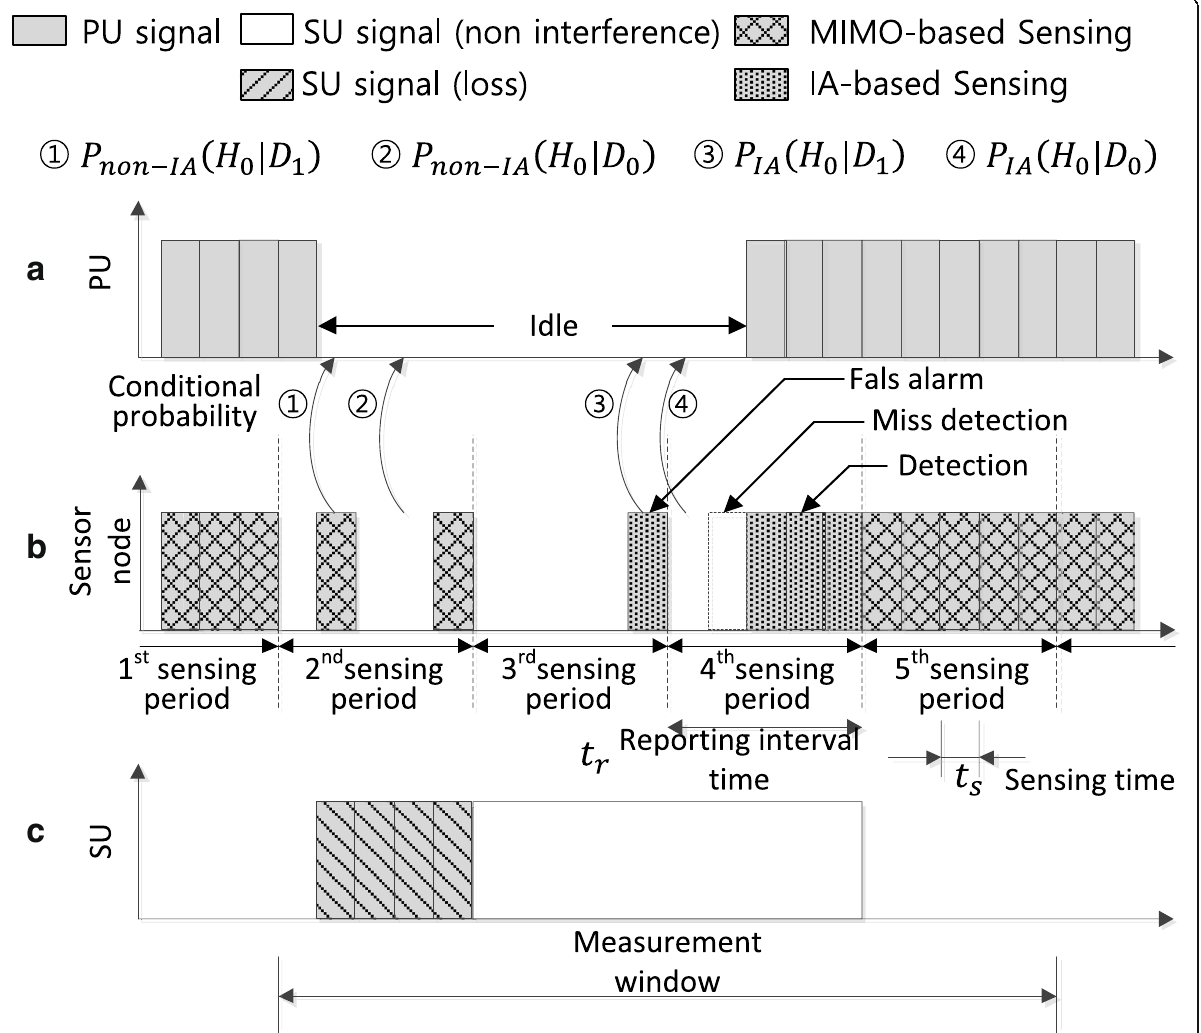
Fig. 6 Transmission opportunity loss ratio. The transmission opportunity loss ratio is the ratio between the conditional probability that the SU misses a transmission opportunity and the PU is idle within the measurement